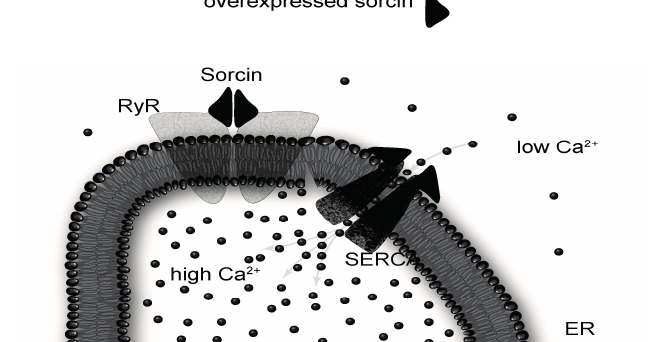
Figure 3. Sorcin inhibits the ryanodine receptor and up-regulates SERCA, increasing calcium load of the endoplasmic